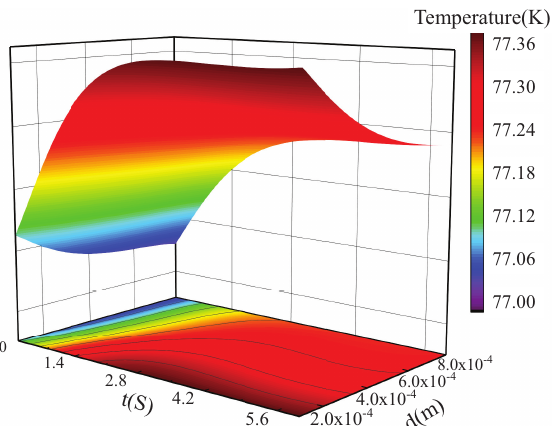
Figure 12. The time evolutions of the temperature of coils with different insulation thicknesses (I max = 50 A, h = 1000 W/(m 2